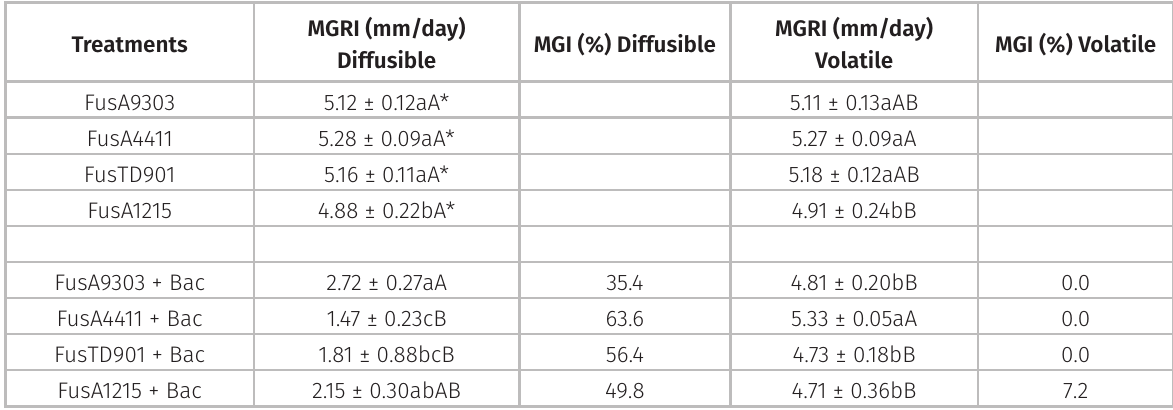
Table II. Mycelial growth rate index (MGRI) of four isolates of Fusarium sp. alone and in the antagonism assay of B. subtilis F62 (Bac) by diffusible and volatile compounds, and the mycelial growth inhibition (MGI) concerning the control observed in 14 th day of